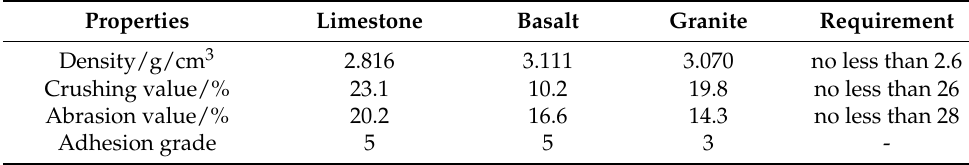
Table 5. Basic performance index of aggregates.